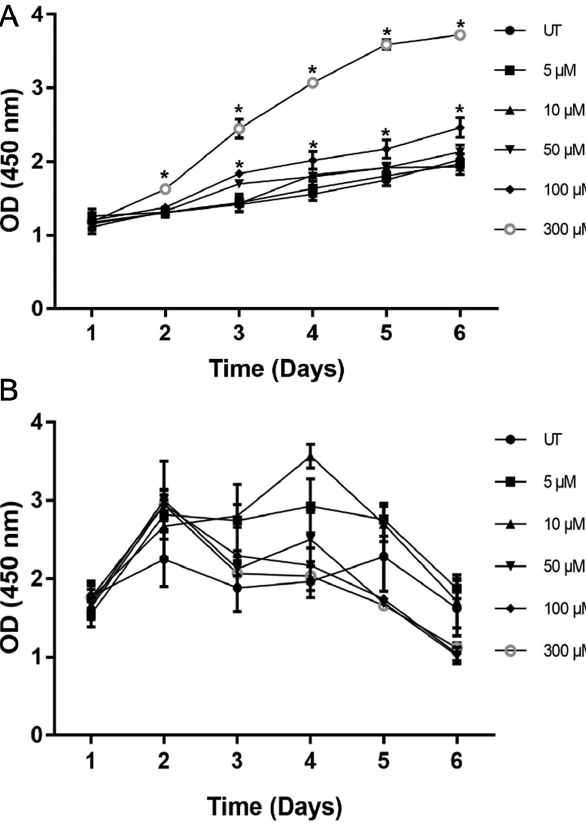
Figure 2. (A) Effects of ST on the proliferation of H508 and (B) SNU-C4 human colon cancer cells. Time course for the effects of increasing concentrations of ST on the proliferation of the cells. Statistical analysis was performed with 2-way ANOVA with Tukey’s post hoc test for multiple comparisons. Values represent mean ± SEM (n = 3). * P < .0001. ANOVA, analysis of variance; SEM, standard error of mean; ST, sodium taurolithocholate.